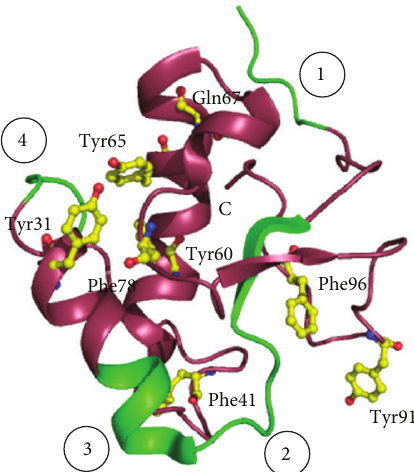
Figure 3: Structure of C-terminal domain of Ole e 9 from olive pollen. The four IgE binding epitopes (in green) marked from 1 to 4 are shown. The aromatic residues which form two distinct sugar binding faces are shown in